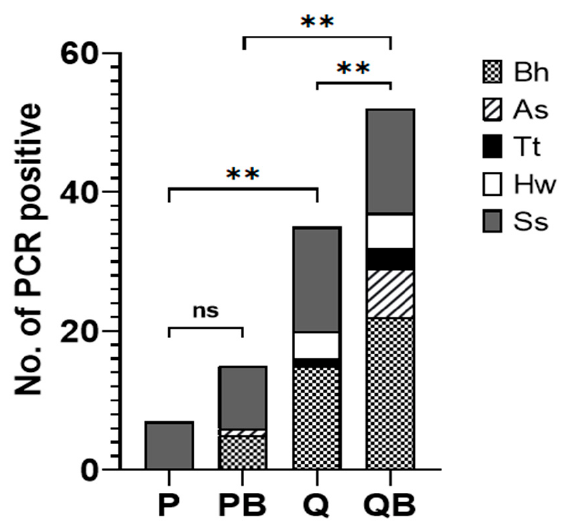
Figure 7. Comparison of the DNA extraction methods for the detection of intestinal parasites. Bh: Blastocystis sp., As: Ascaris lumbricoides , Tt: Trichuris trichiura , Hw: hookworm, Ss: Strongyloides stercoralis . ** Statistical differences using chi-square test ( p < 0.01), ns: non-significant differences ( p > 0.05).